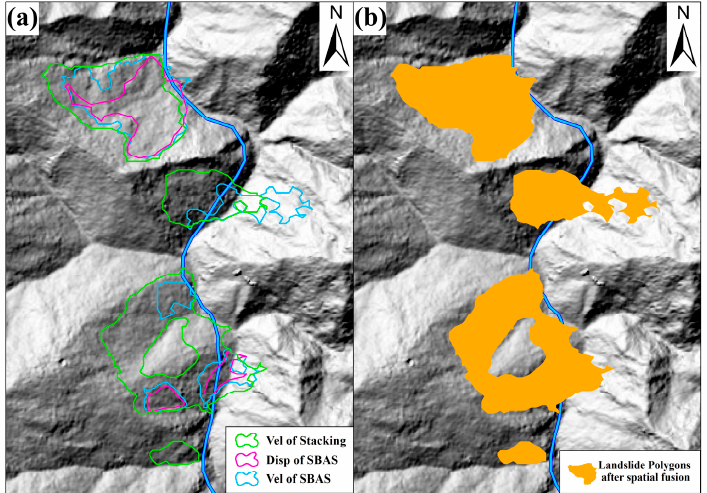
Figure 5. Landslide spatial fusion. ( a ) Landslide boundary identified by three deformation maps. ( b ) Landslide boundary after spatial fusion.